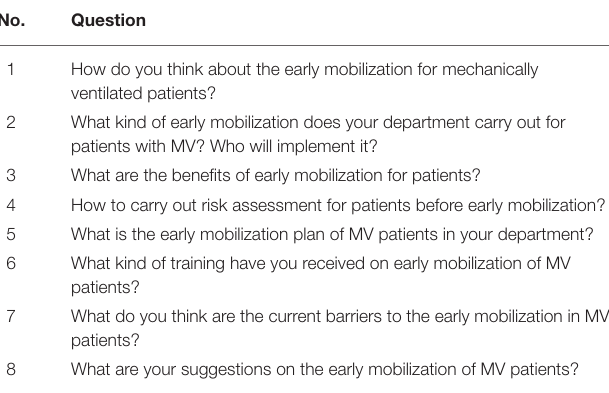
TABLE 1 | Questions for interviewing nurses about perception on the early mobilization of MV patients in the ICU.